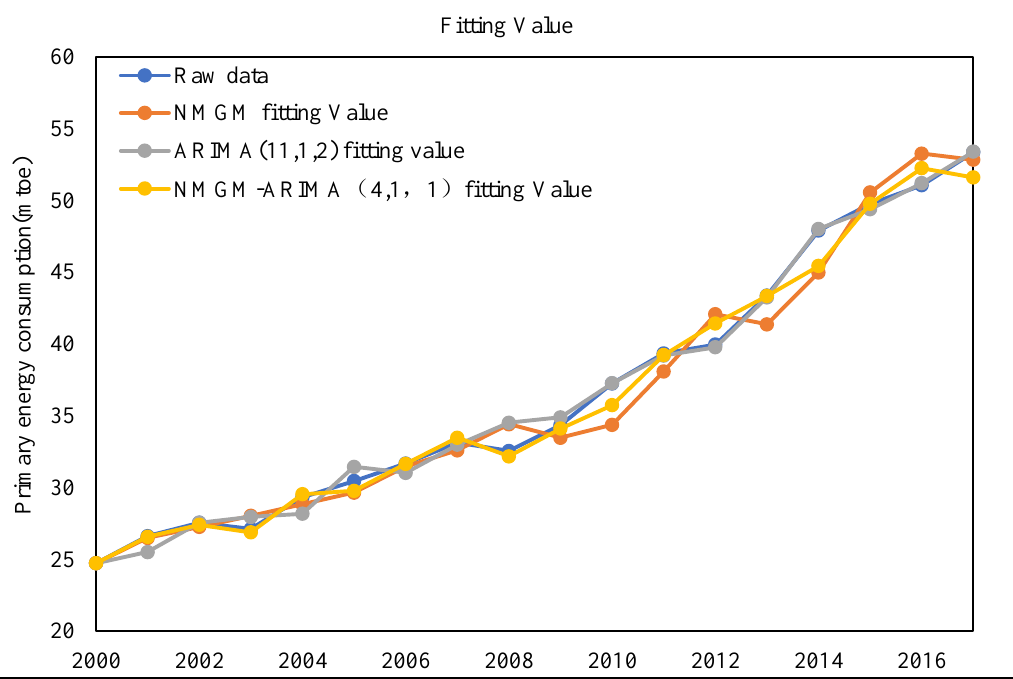
Figure 10. Comparison of NMGM and NMGM-ARIMA.